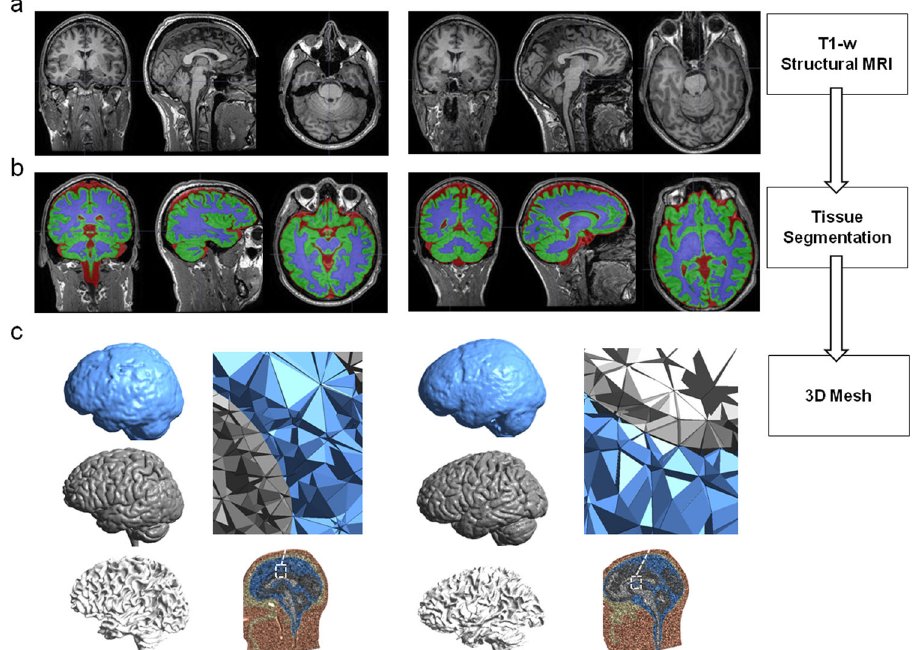
Fig. 3 Image processing and mesh creation diagram. We show the pipeline of image processing to create a 3D mesh to run the simulations for two participants in the study as an example, one cosmonaut (left) and one control participant (right). a We collected the T1-weighted (T1- w) anatomical scan for each participant on three time-points (pre- fl ight, post- fl ight, and follow-up). In the fi gure, we show MRIs collected pre- fl ight for both participants. b We ran the headreco + CAT pipeline from SimNIBS 13 to segment the T1 anatomical image into class types (skin, bone, CSF, eyes, gray matter, and white matter). For better visualization, we show segmentation of CSF (red), gray matter (green), and white matter (blue). c We then computed the head volume 3D meshes composed of tetrahedral elements (CSF: blue; gray matter: gray; white